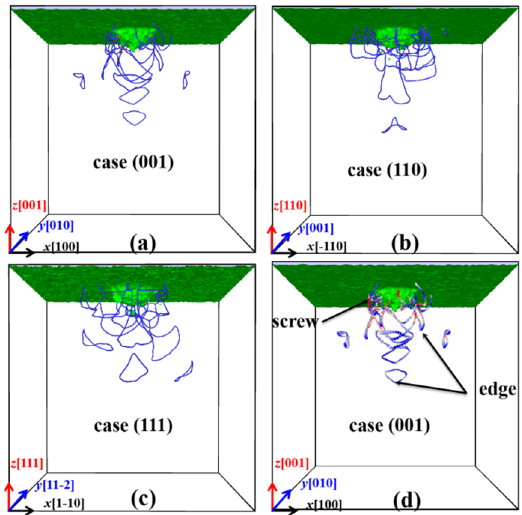
Figure 7. Dislocations of the indented ZnSe nano films with maximum indentation depth of 5.0 nm. Blue lines in ( a – c ) represent the 1/2<110> type dislocations. Blue, red, and white arrows in ( d ) represent the edge, screw, and mixed dislocations.